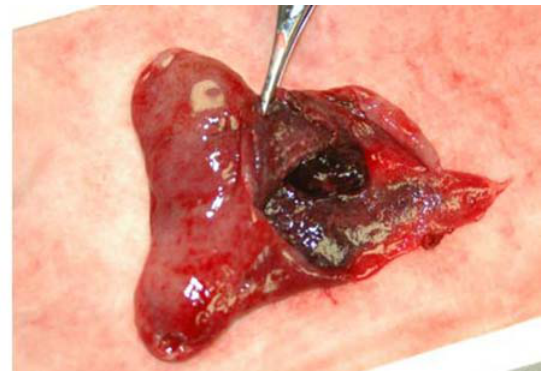
Figure 2. The tissue from Case 1, open and showing blood clots and